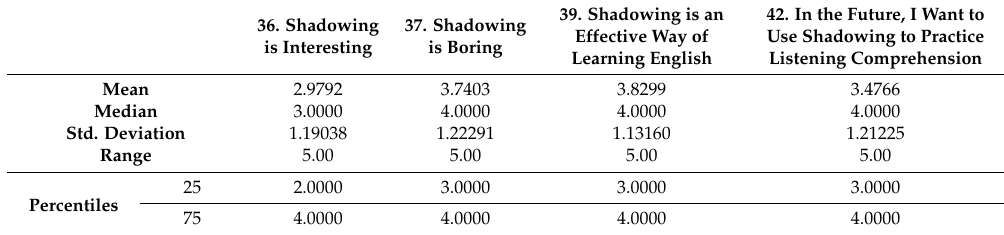
Table 3. Select attitudes towards